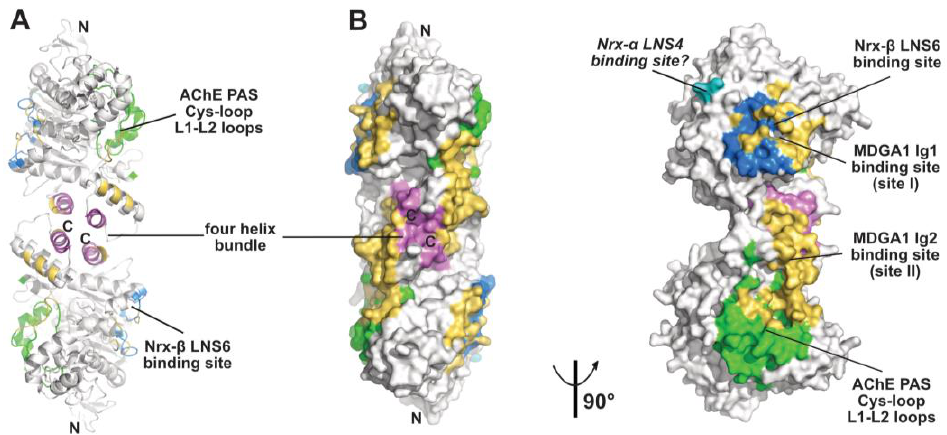
Figure 3. Overall view of the neuroligin NL2 dimer displayed in the ribbon ( A ) and surface modes ( B ) (with the left and right NL2 dimers oriented 90° from each other), with the binding surfaces for neurexin-β or the neurexin-α LNS6 domain (modeled from PDB code 5XEQ) and for the neurexin-α LNS4 domain displayed in blue and cyan, respectively, and those for the MDGA1 Ig1 and Ig2 domains in gold. The Cys-loop and L1-L2 loops, which correspond to the long Ω loop and vicinal loops at the AChE PAS, are displayed in green and helices α3(7,8) and α10 in the dimer four-helix bundle in violet. The N- and C-termini are indicated.